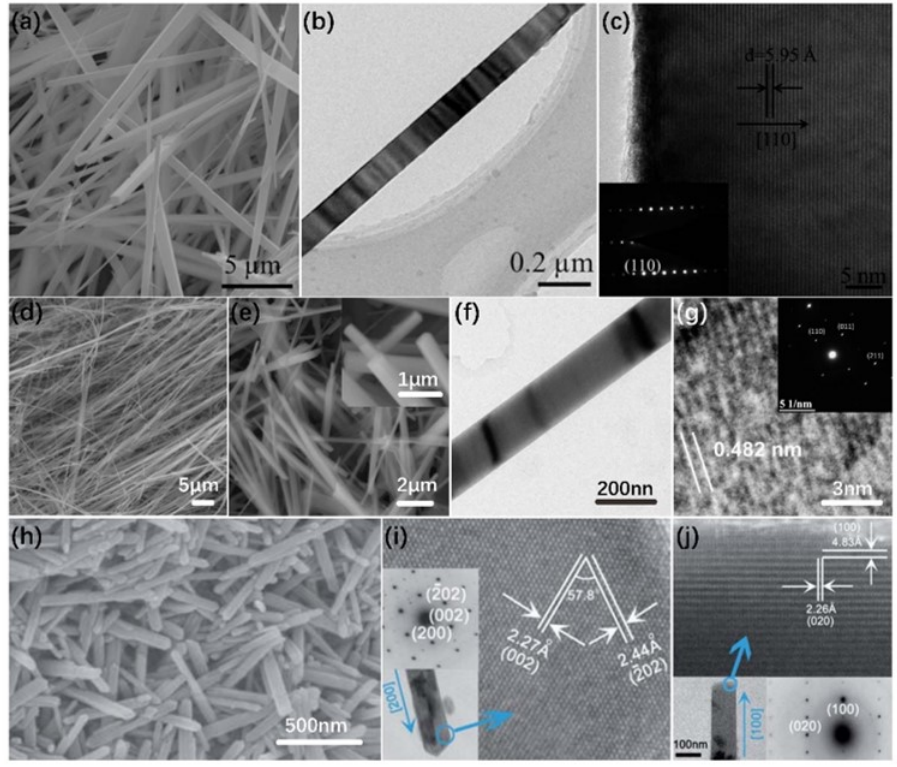
Figure 4. ( a ) SEM image of the VO 2 (A) nanowires (NWs) and ( b ) low-resolution TEM image of individual VO 2 (A) NW. ( c ) HRTEM image of the end of the VO 2 (A) NW, and the inset is the corresponding SAED pattern. Reproduced from [29], with permission from Royal Society of Chemistry, 2014. ( d ) SEM image of V 3 O 7 · H 2 O NWs. ( e ) SEM image of monoclinic VO 2 (M) NWs; the inset in ( e ) indicates rectangular cross-sections of VO 2 (M) NWs. ( f ) TEM image of a monoclinic VO 2 (M) NW. ( g ) HRTEM image of a monoclinic M1 phase VO 2 NW; the inset in ( d ) shows the corresponding SAED pattern. Reproduced from [33], with permission from American Chemical Society, 2014. ( h ) SEM image of VO 2 (M) NRs. ( i , j ) HRTEM images and SAED patterns of two individual VO 2 (M) nanorods (NRs); insets are their corresponding SAED patterns and the morphologies of the selected NRs. Reproduced from [54], with permission from Royal Society of Chemistry,